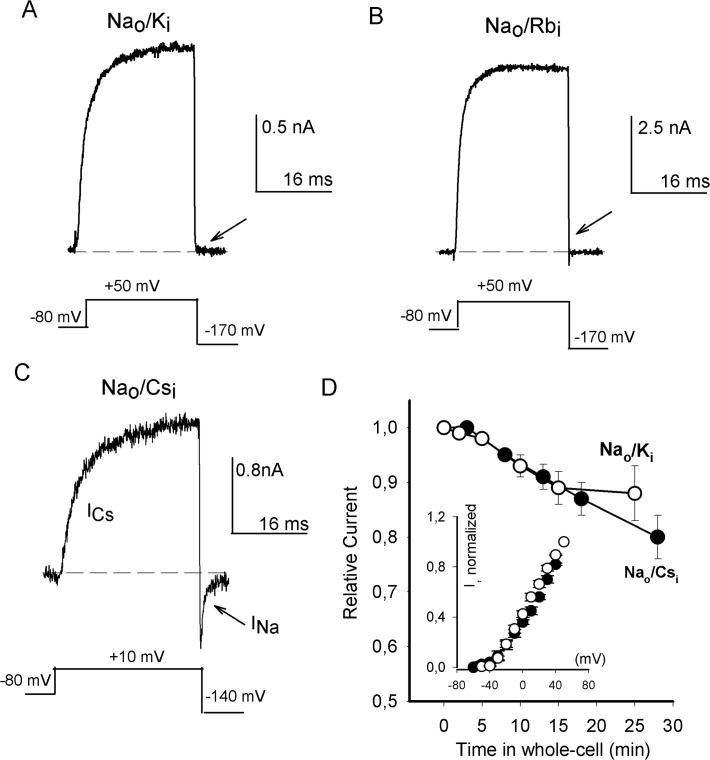
Ion fluxes through Shab channels.(A) IK evoked by a +50mV/30ms depolarization followed by hyperpolarization to -170 mV, as indicated (Nao/Ki solutions). (B) IRb evoked as in A (Nao/Rbi). (C) Outward ICs evoked by a +10mV/30ms pulse. At pulse end the membrane was hyperpolarized to -140 mV, and an inward INa was recorded, as indicated (Nao/Csi). (D) Relative current vs. time of recording. Relative current = (I(t)/I(0); I(0) is the current amplitude at the beginning of the recording, I(t) is the current remaining at time t, with the cell bathed in either Nao/Ki (open circles) or Nao/Csi solutions (closed circles), as indicated (see Text). Inset: average normalized outward current recorded in the same solutions (n = 8).